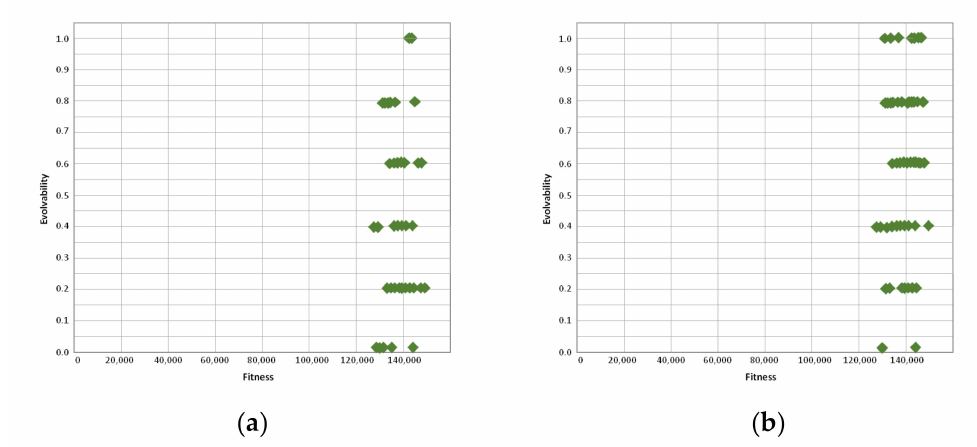
Figure 21. The evolvability in case of cycle crossover ( a ) and 2-opt operator ( b